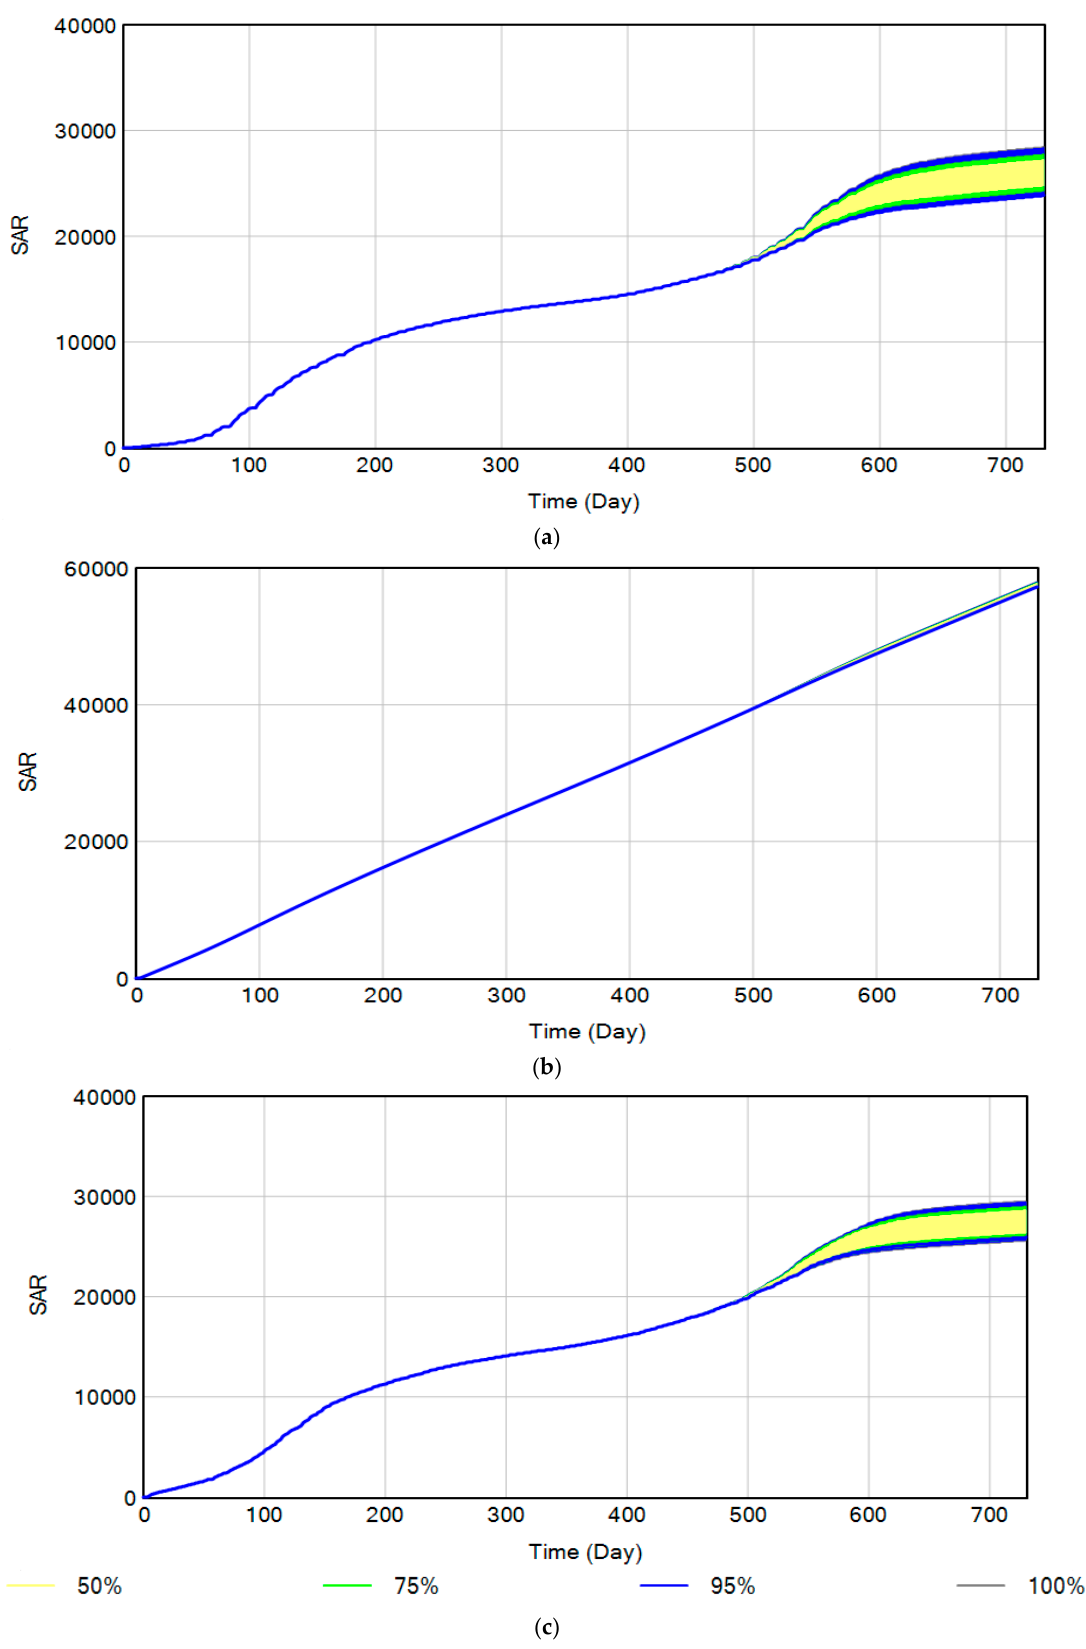
Figure 8. Total inventory management cost sensitivity graphs under the influence of vaccination efficacy for policies ( a ) POP ( b ) JIT and ( c )